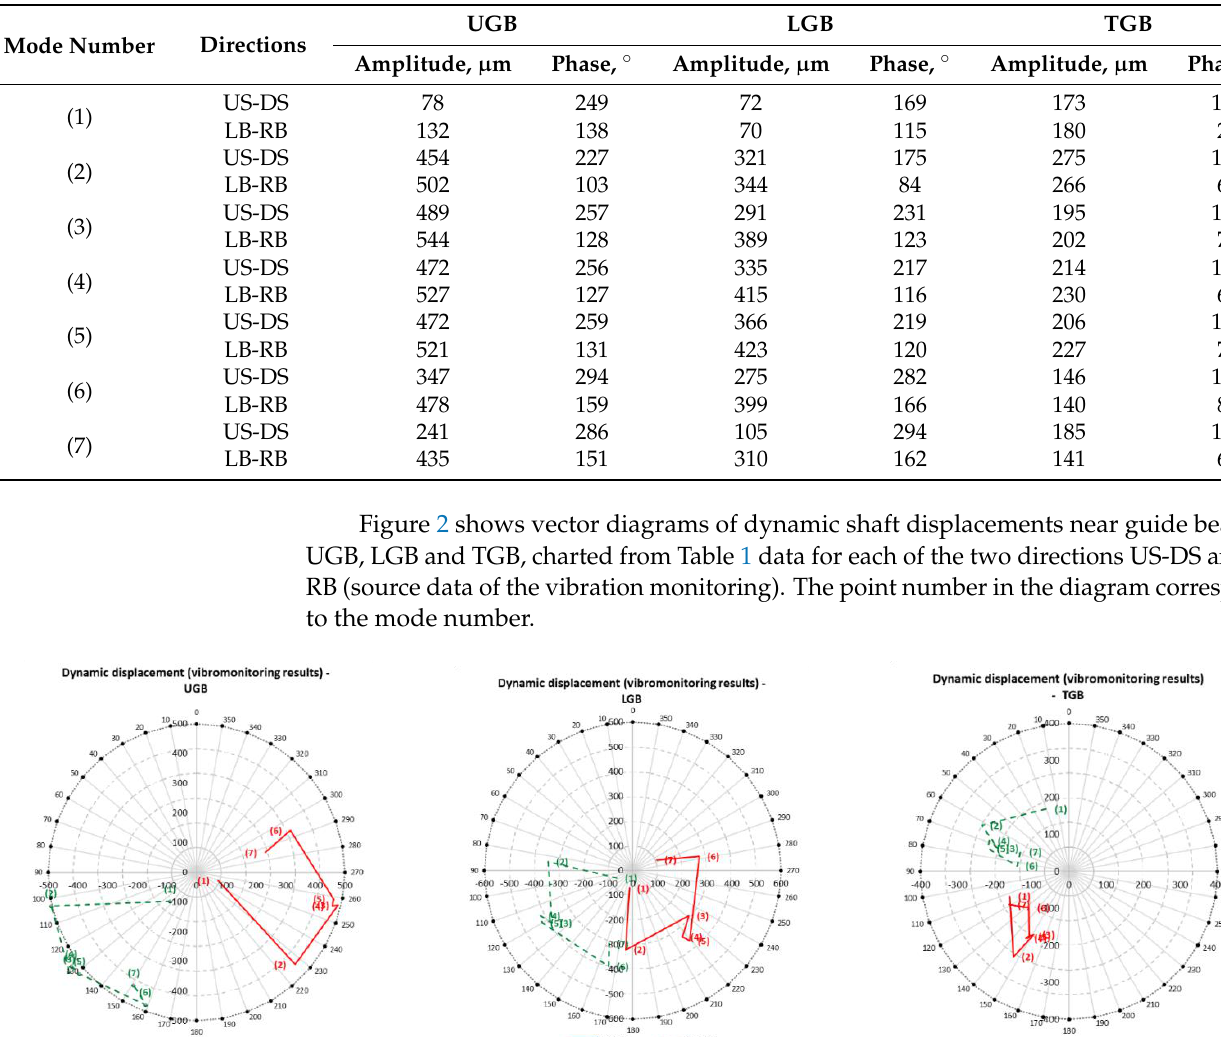
Table 1. Initial vibration monitoring data (1st harmonic).